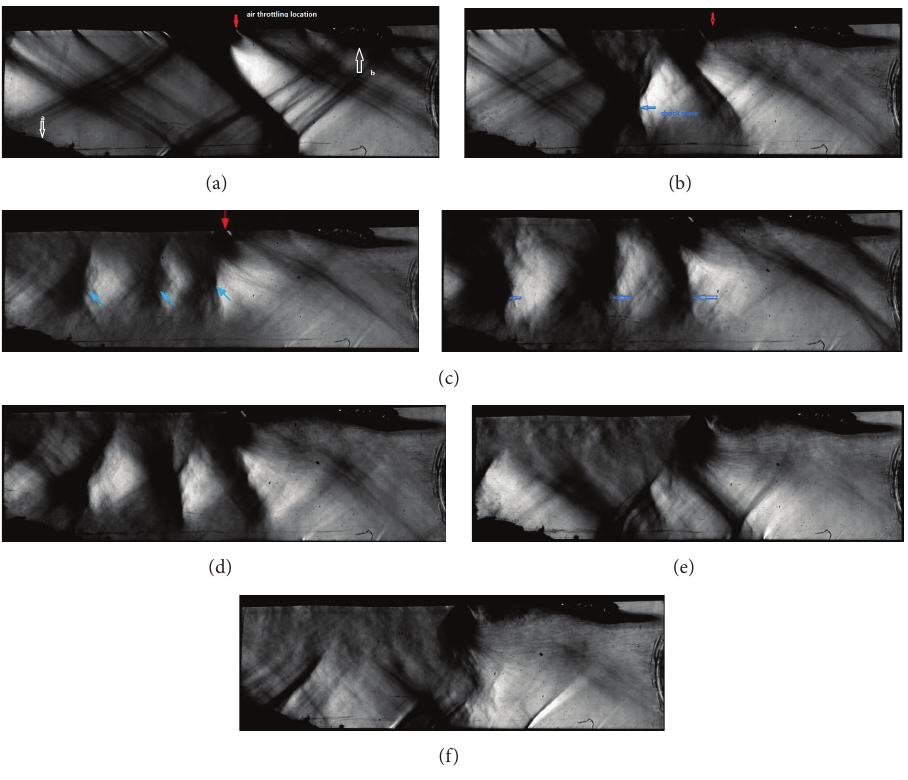
Figure 12: Schlieren graphs of the expansion region with air throttling at the location of 745 mm from the entrance of the combustor at different times (a ∼